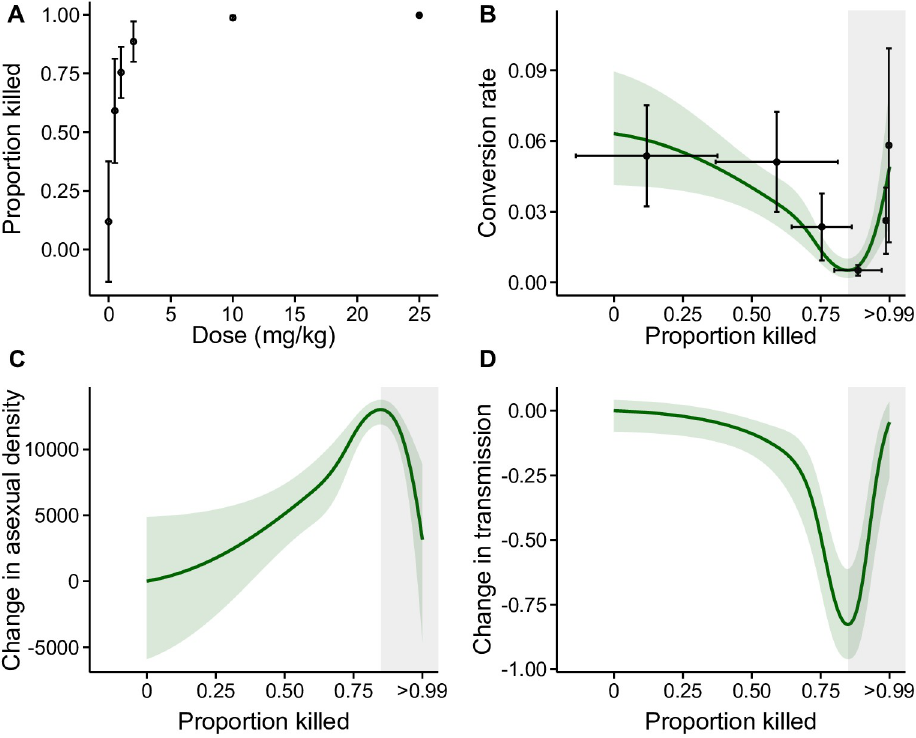
Fig 3. P . chabaudi parasites in vivo adjust conversion rate in response to a loss of state in a non-linear manner. ( A ) Dose-response curve for the proportional change in asexual density (“state”) after drug treatment. Note, at the highest drug doses, > 99% but < 100% of asexuals are lost and because infections were treated post peak, densities also decline in the untreated control infections. ( B ) Parasites reduce conversion in response to losing up to 85% of their number (reproductive restraint) and then switch to increasing conversion (terminal investment; grey shaded area). Following [54], conversion rate is estimated for each infection based on gametocyte, asexual and RBC dynamics (see S2 Fig). Mean ± SEM conversion rates are presented in black. The observed conversion rate strategies have short-term fitness consequences in terms of within-host survival ( C ) and between host transmission ( D ). Specifically, relative to untreated infections, reproductive restraint increases replication rate ( C ) but reduces the estimated probability of between-host transmission (translated from gametocyte densities according to [61]) ( D ). All green lines and green shaded areas are the predicted relationships ± SEM between parasite strategies and the loss of state from a generalised additive model, and grey shaded areas represent the region in which parasites make a terminal